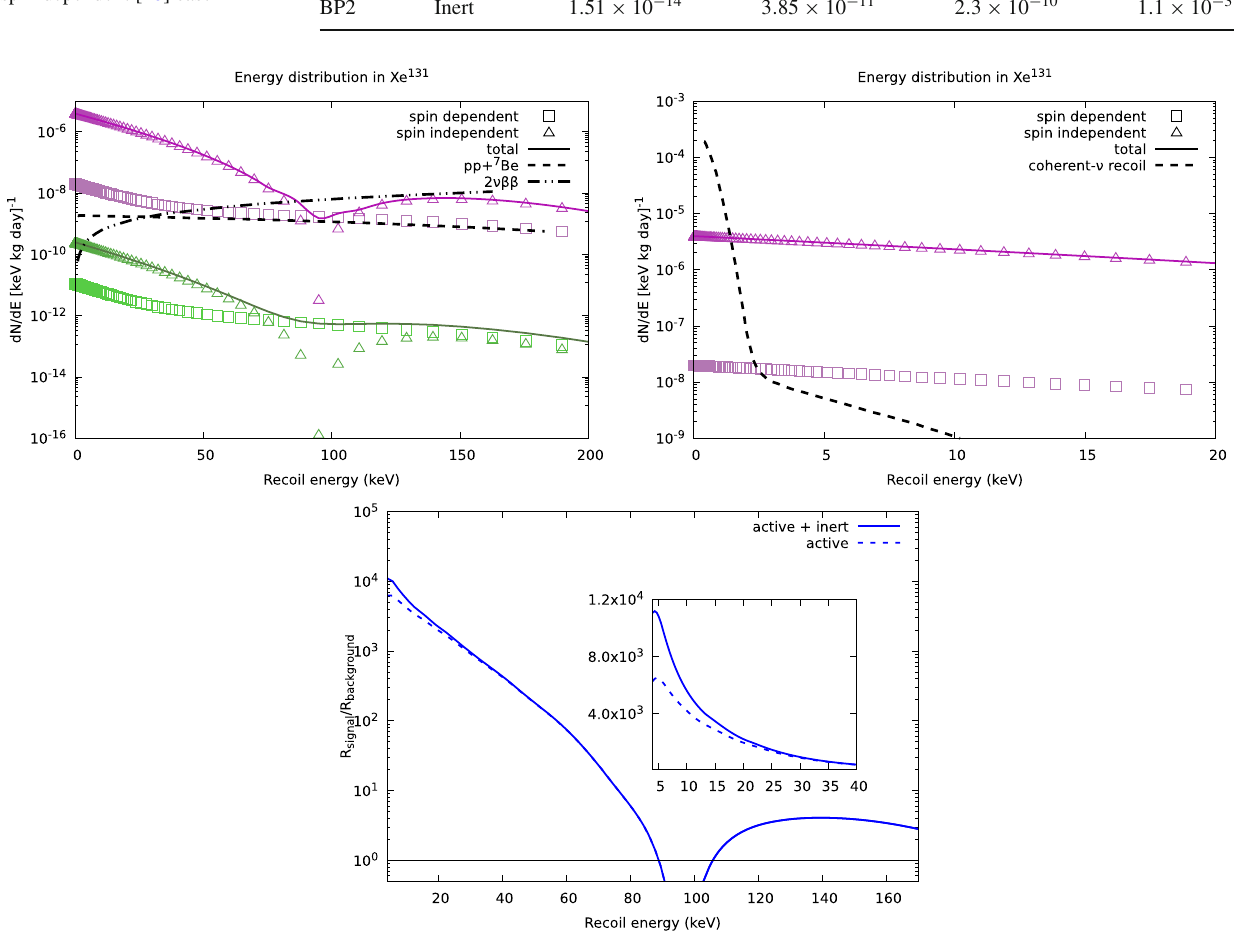
Fig. 5 (Top left) Nuclear recoil spectrum for the selected BP2 in a liq- uid Xe detector (BP1 results are the same), for both the active (purple) and inert (green) neutralino. Also shown (black) are the expected back- grounds [49,52]. (Top right) We show the coherent neutrino nuclear recoil scattering, which affects in the low recoil energy spectrum. (Bot-